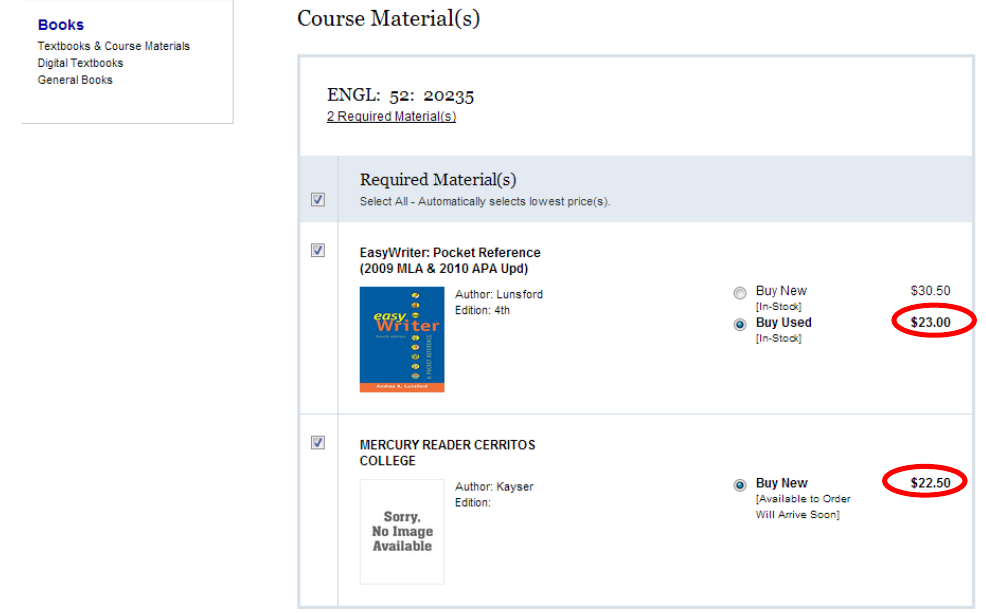
Figure 3 . Example 2 for finding an average section textbook